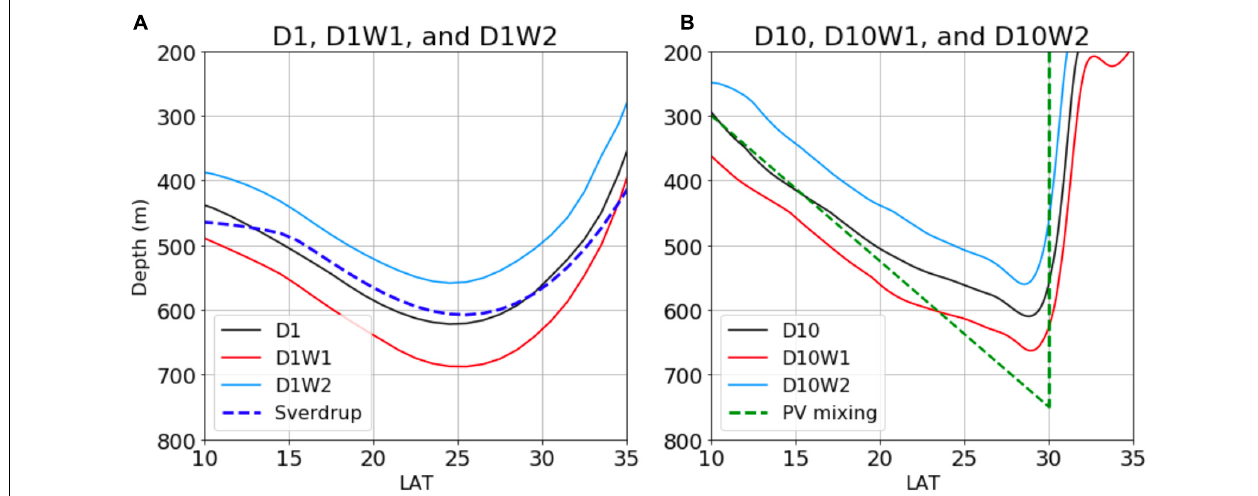
FIGURE 12 | Comparison of the thermocline depth along 12 ◦ E between the numerical and analytical solutions. (A) The coarse-grid (1 ◦ ) numerical solutions using different wind profiles (solid lines); (B) same as (A) but the numerical solutions are from eddy-resolving (1/10 ◦ ) calculations. Analytical solutions for two theories based on reference cases (D1 and D10) are marked by dashed